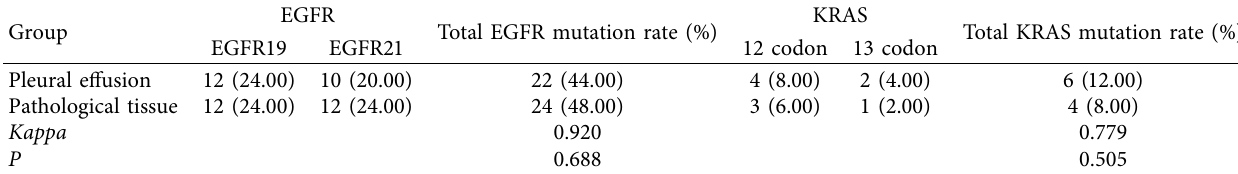
Table 1: EGFR/KRAS gene mutation results ( n � 50%).